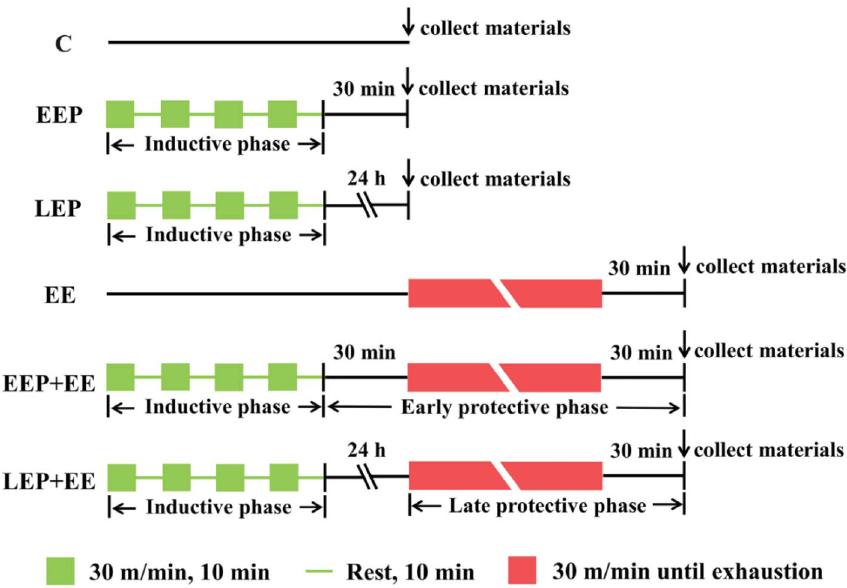
Figure 1. Experimental protocol 24 . C, control group; EEP, early exercise preconditioning group; LEP, late exercise preconditioning group; EE, exhaustive exercise group; EEP + EE, early exercise preconditioning plus exhaustive exercise group; LEP + EE, late exercise preconditioning plus exhaustive exercise